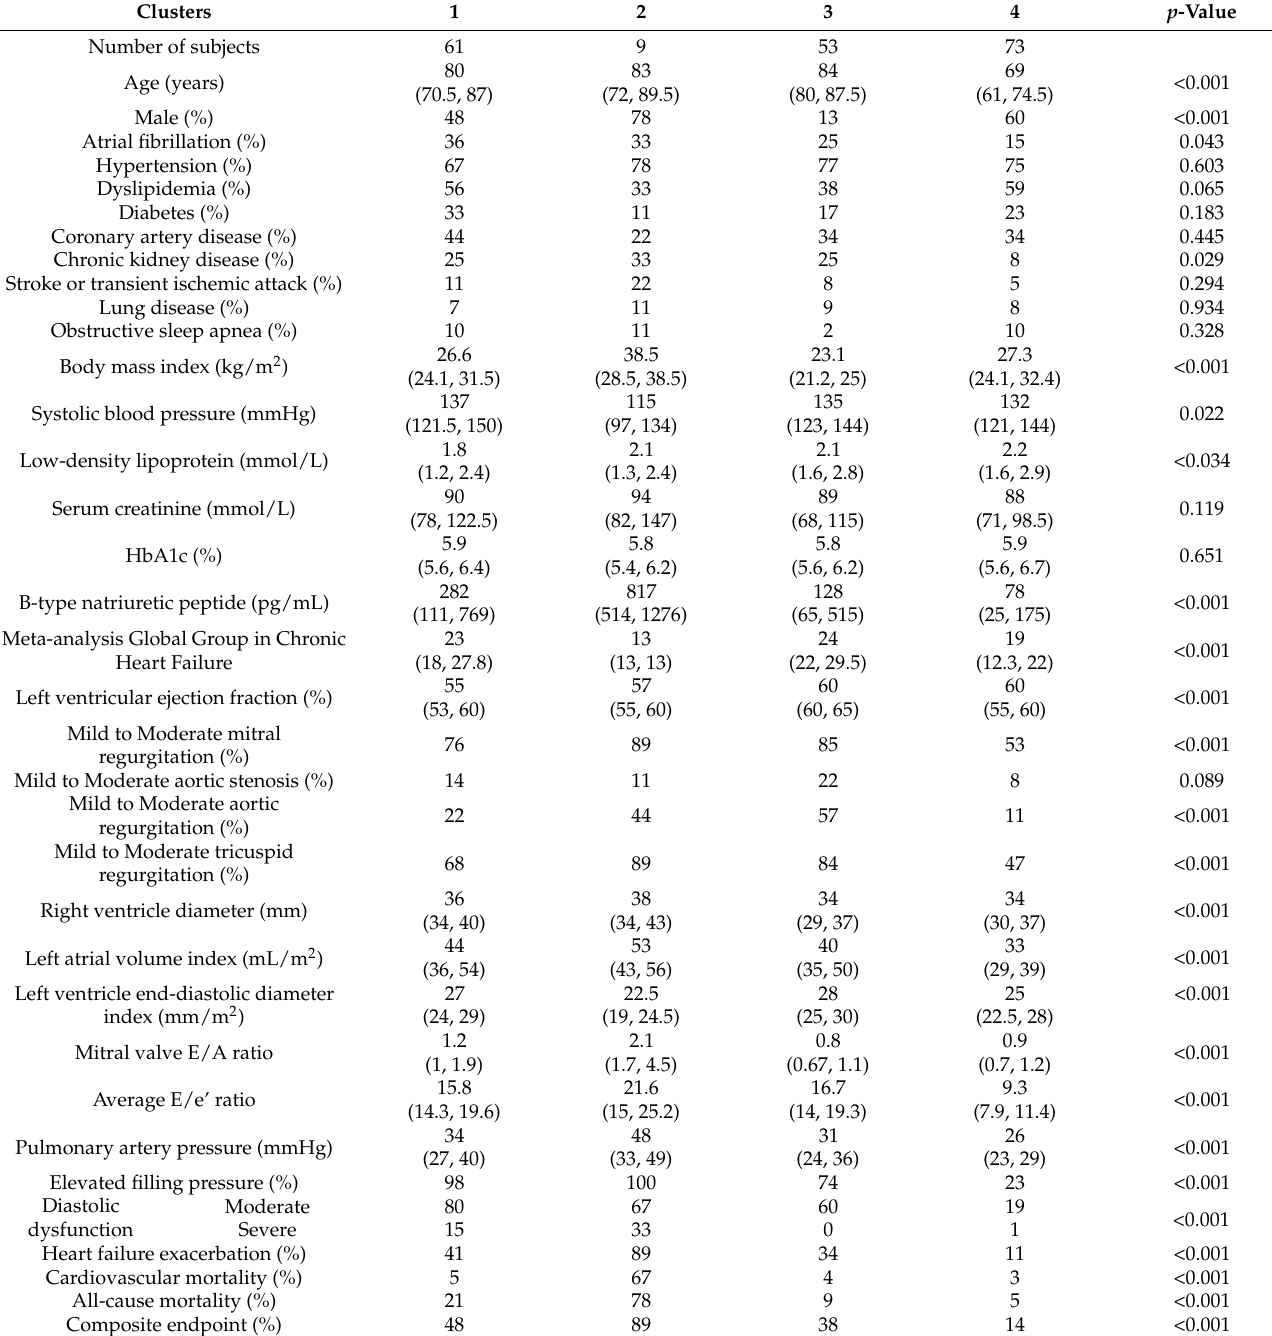
Table 2. Summary of clusters using the K-prototype method ( n =